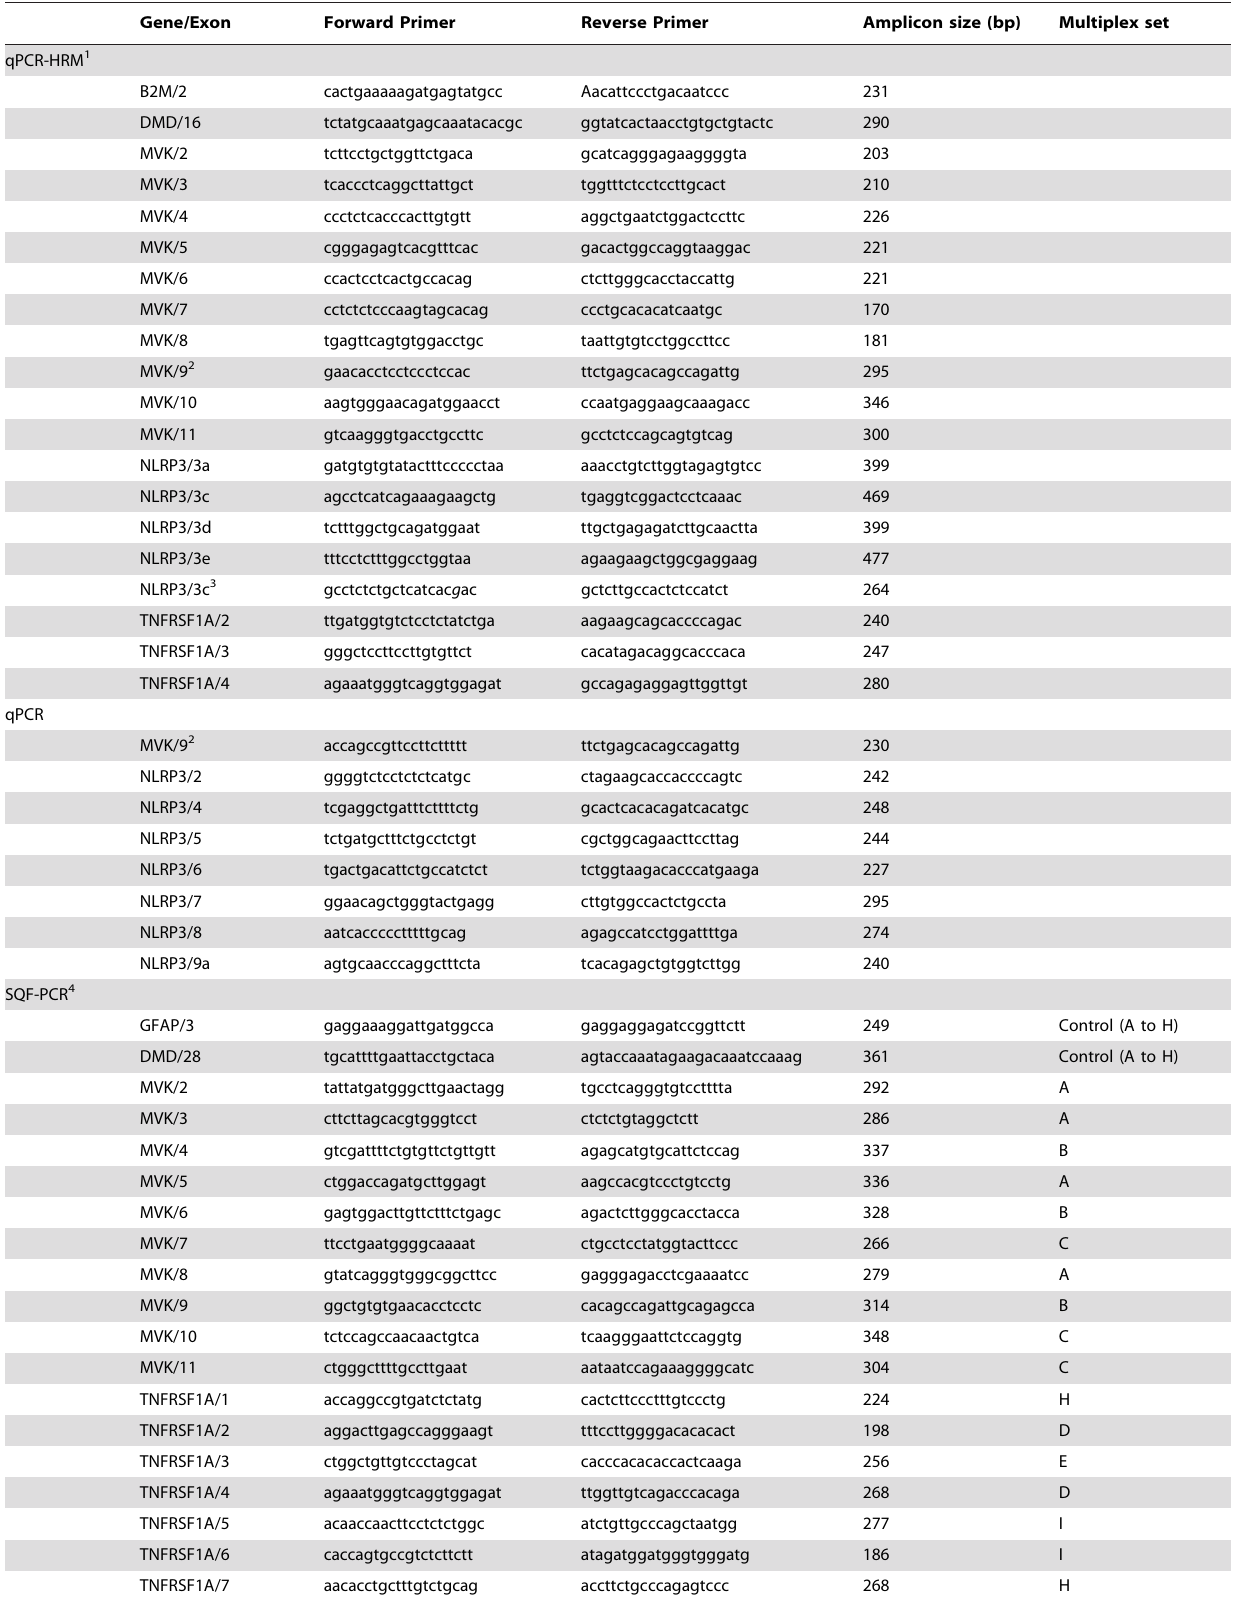
Table 1. Primers used in this